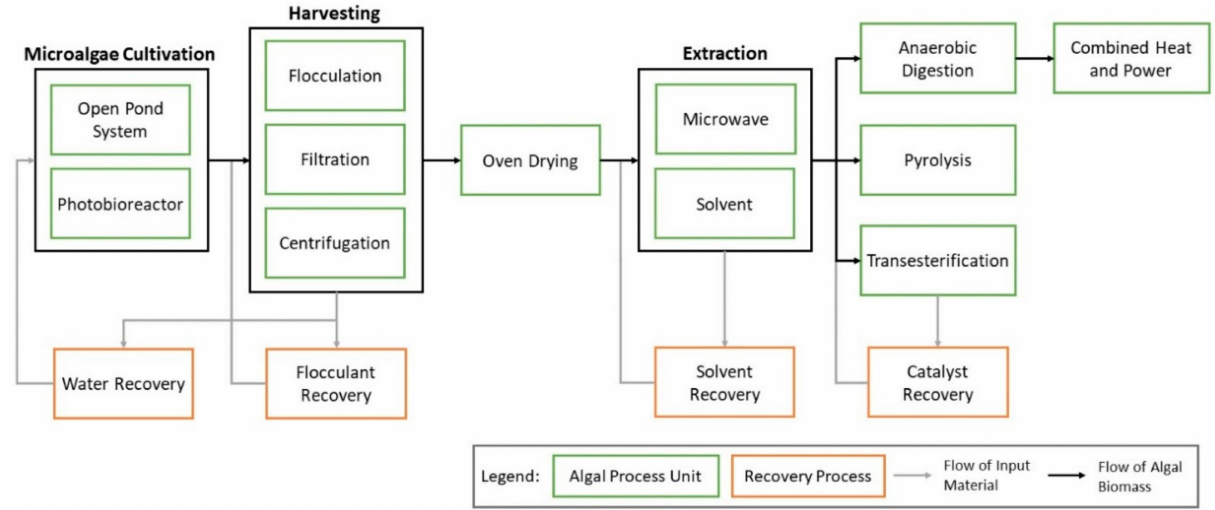
Figure 1. Algal biorefinery process